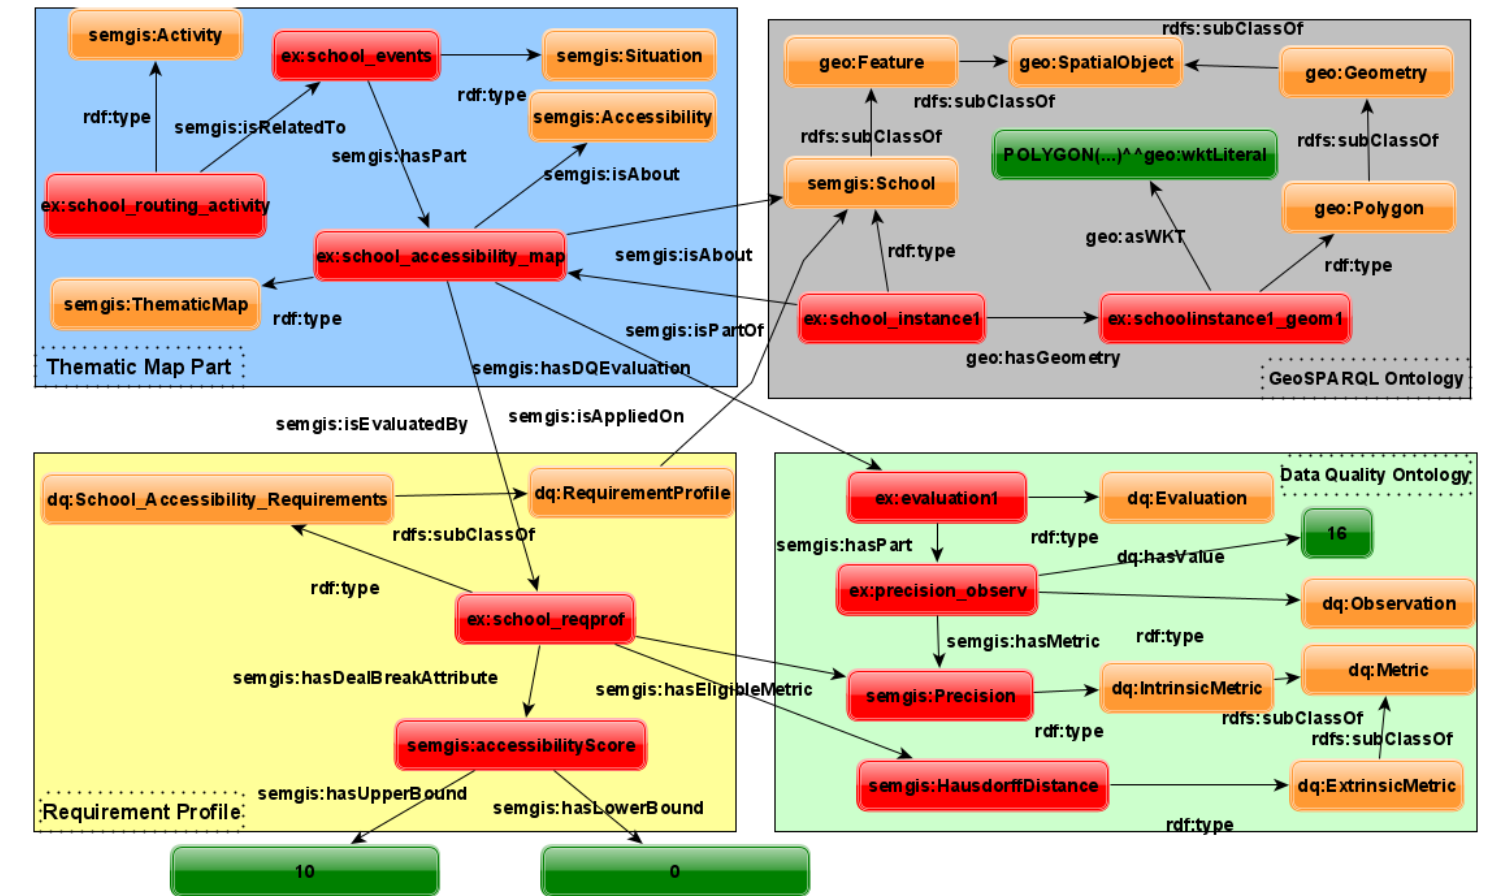
Figure 6. Example individual implementing the complete ontology model: A school modeled as school_instance1 is connected to its geometry using the GeoSPARQL vocabulary. The school instance is related to the new Thematic Map vocabulary visa the isPartOf relation. The Thematic Map instance relates to a set of evaluations which are the results of data quality assessments. In addition, the thematic map relates to one or more requirement profiles which relate to a set of criteria, shown here with the condition of an accessibility constraint. Thematic map instances are classified and may related to a situational